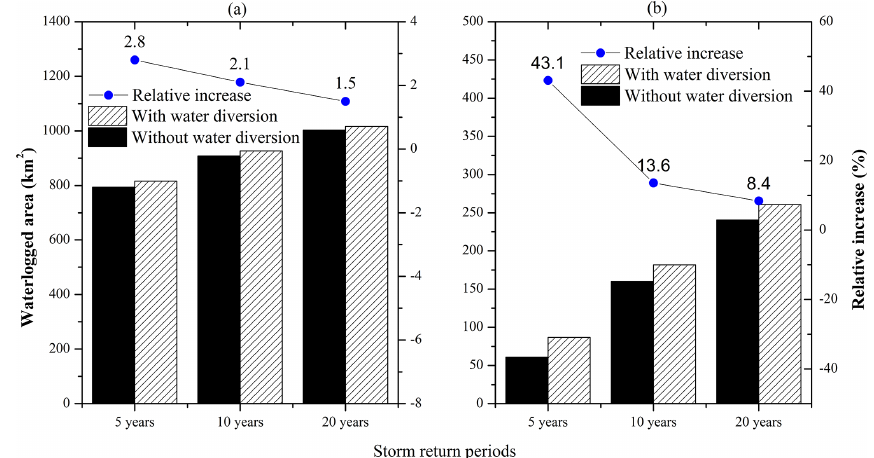
Figure 8. Changes in waterlogging areas in the lakeside area under the influence of water diversion (shaded bar) and no diversion (black bar). The black line represents the trend of the relative increase in waterlogged area caused by water diversion.